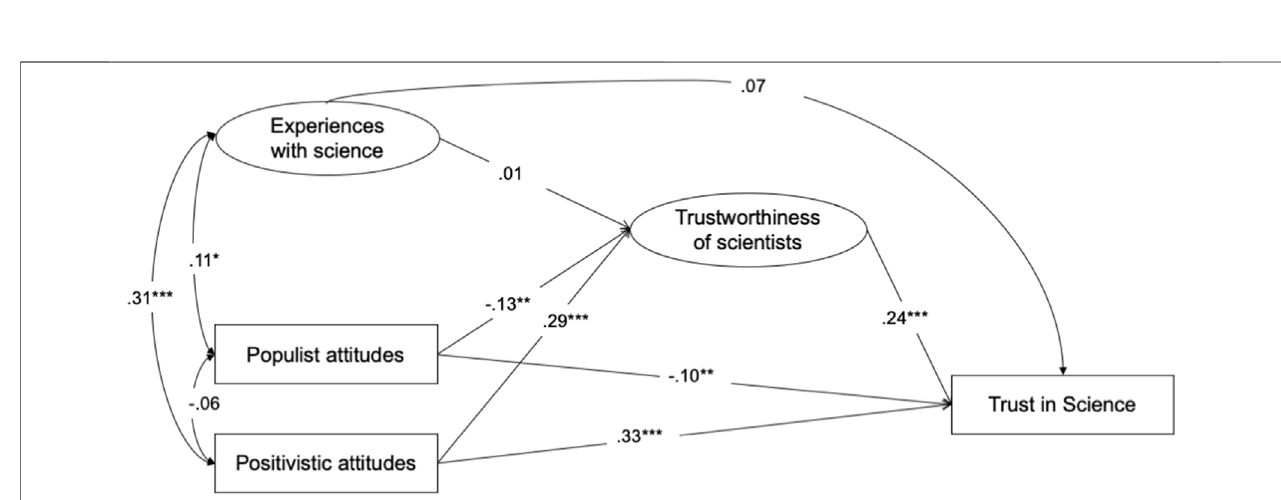
FIGURE 3 | Structural Model ( N (cid:1) 742); path coef fi cients are standardized estimates; ** p < 0.01; *** p < 0.001.